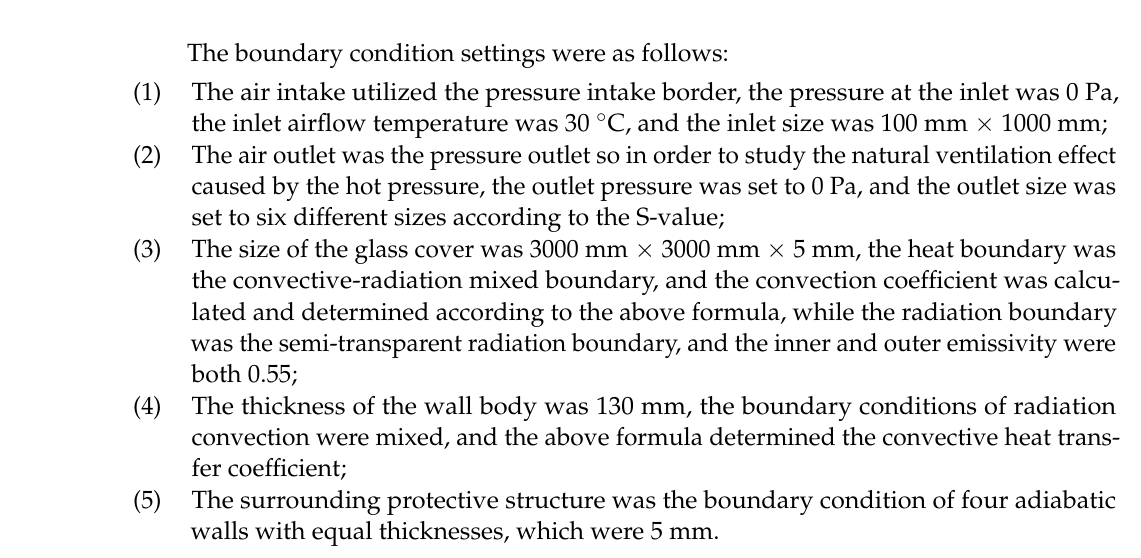
Table 2. Solar irradiance in Urumqi at 12:00 on 15 June 2022. Vertical Scattered Horizontal Scattered Ground Vertical Direction Direct Irradiation Radiation Radiation Reflected Radiation Solar irradiance (W/m 2 ) 853.125 100.462 112.172